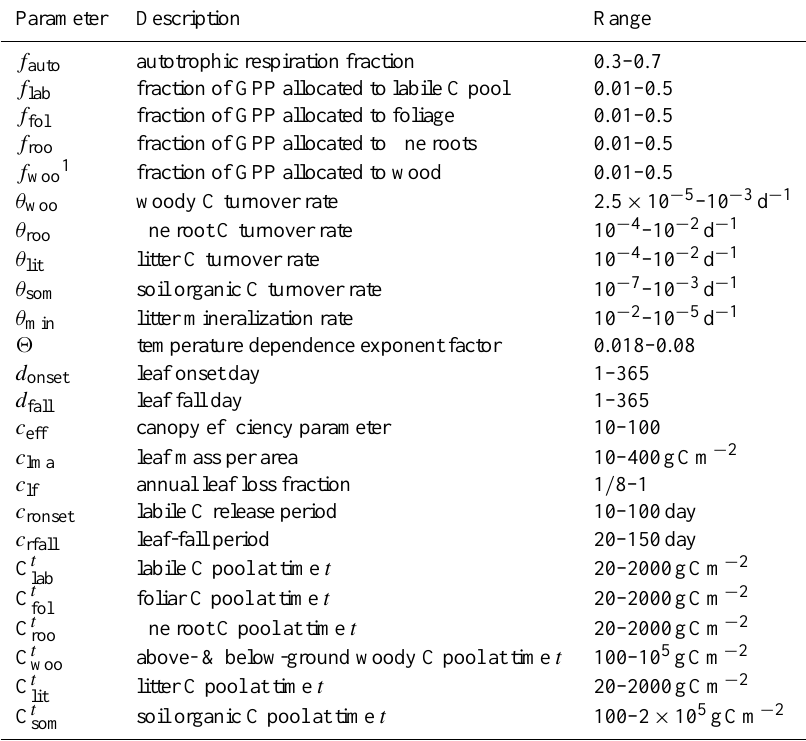
Table 1. DALEC2 model parameters, descriptions, and minimum–maximum parameter values: the corresponding DALEC2 equations are fully described in Appendix